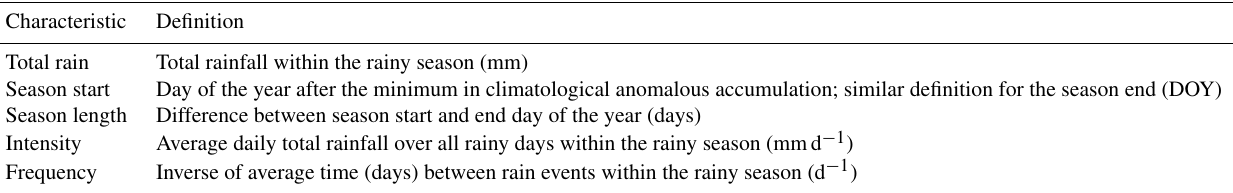
Table 3. Definitions of the different rainy-season characteristics used in this study. Characteristic